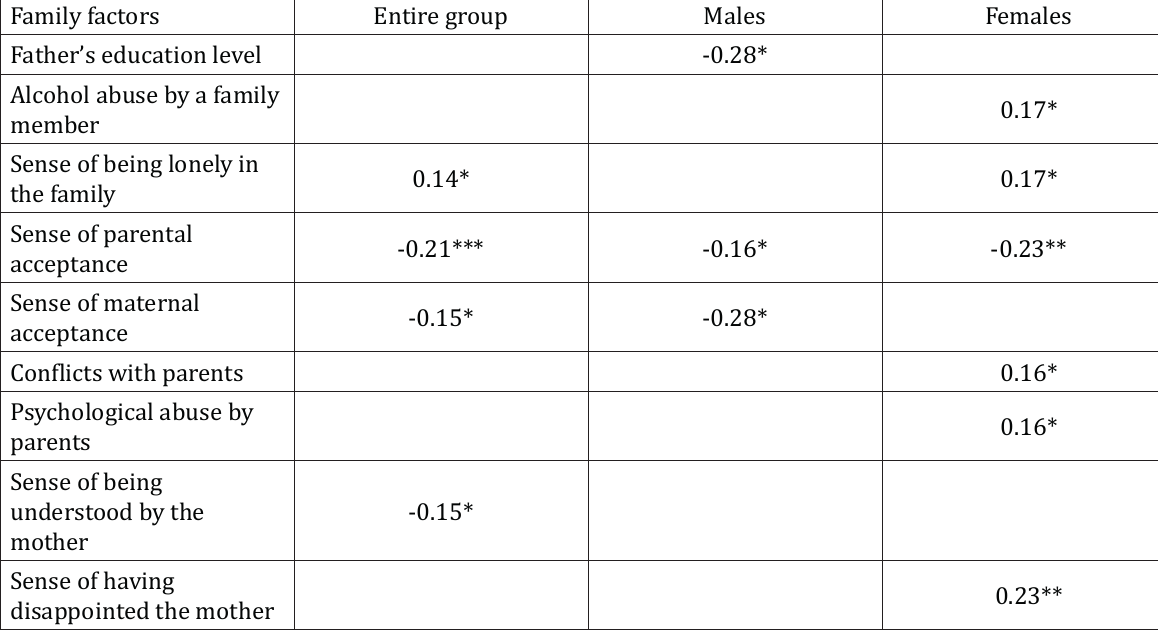
Table 1. Correlation coefficients between daily SNS usage (in hours) and family factors